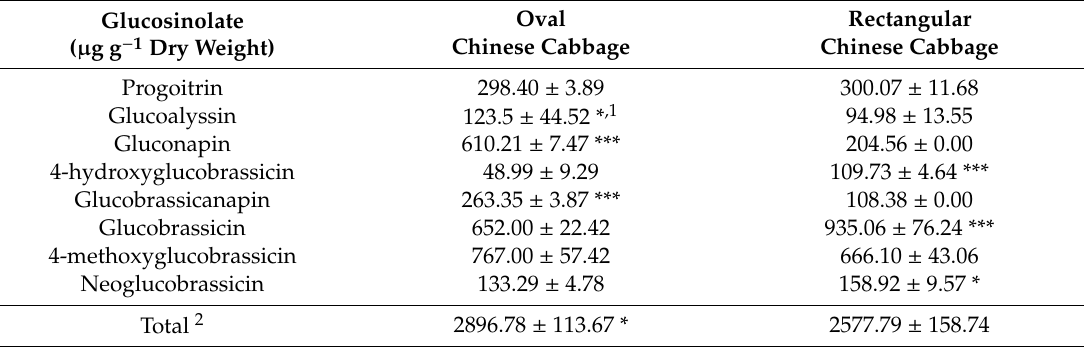
Table 1. Glucosinolate contents in oval and rectangular Chinese